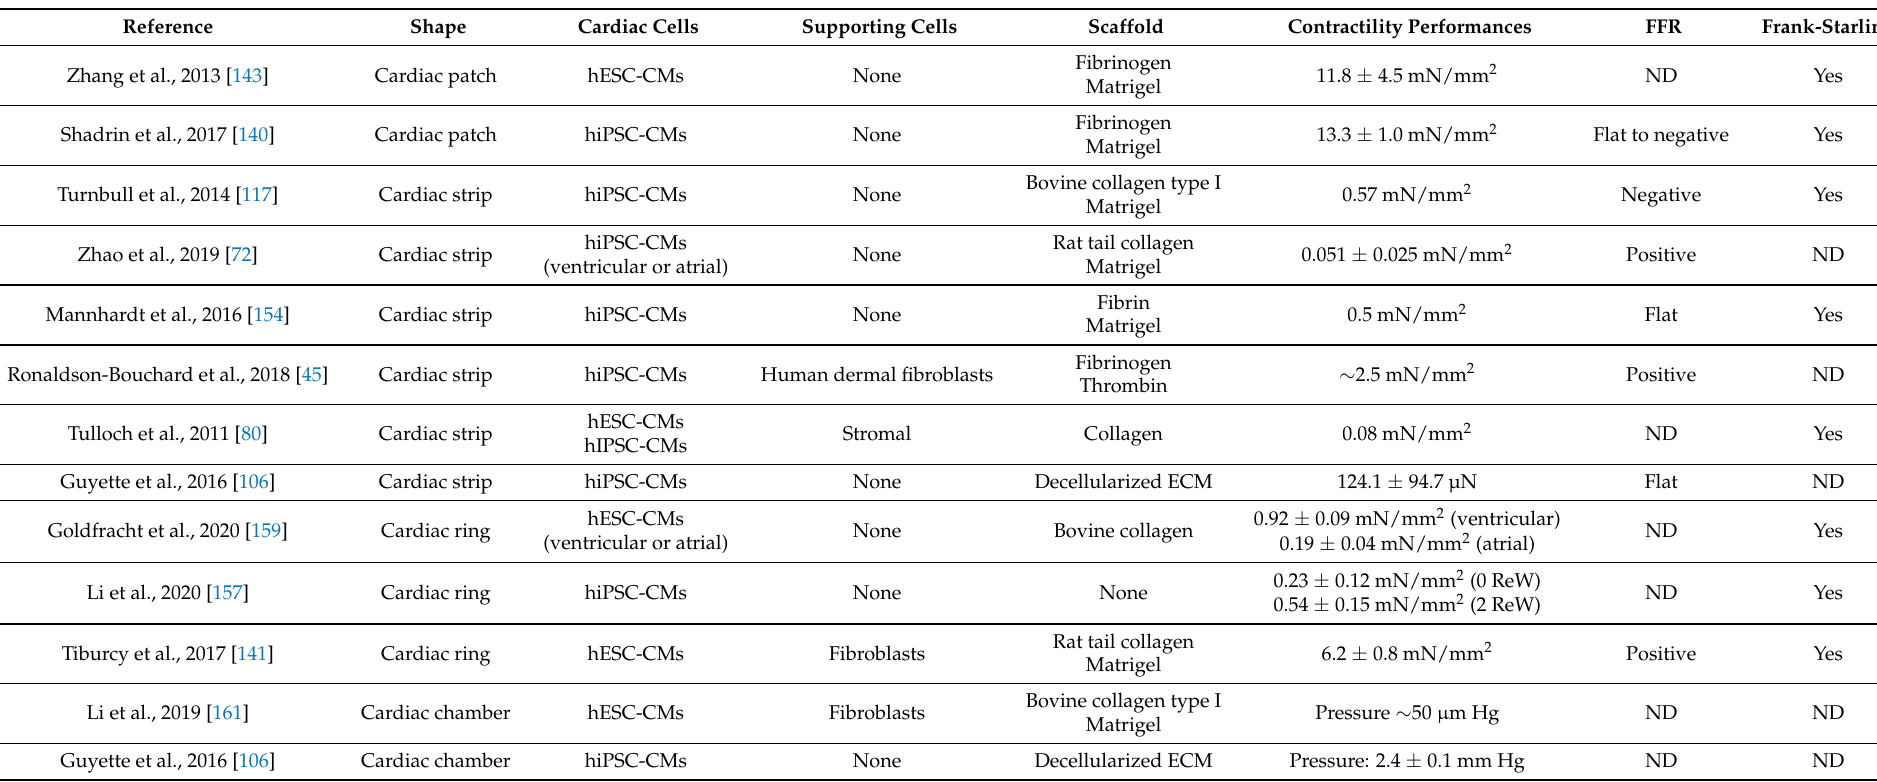
Table 1. Table summarizing the characteristics of some engineered cardiac tissues from hiPSC-CMs or hESC-CMs in the literature. FFR: Force–Frequency Relationship. ND: Not